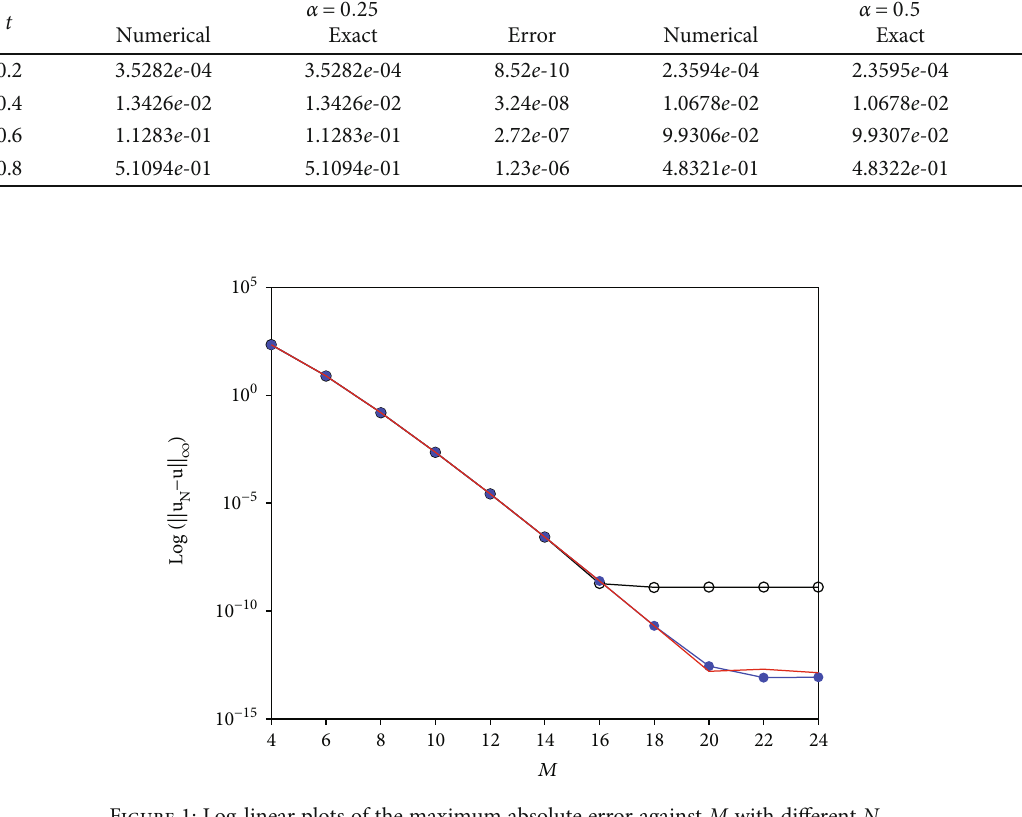
Figure 1: Log-linear plots of the maximum absolute error against M with di ff erent N .